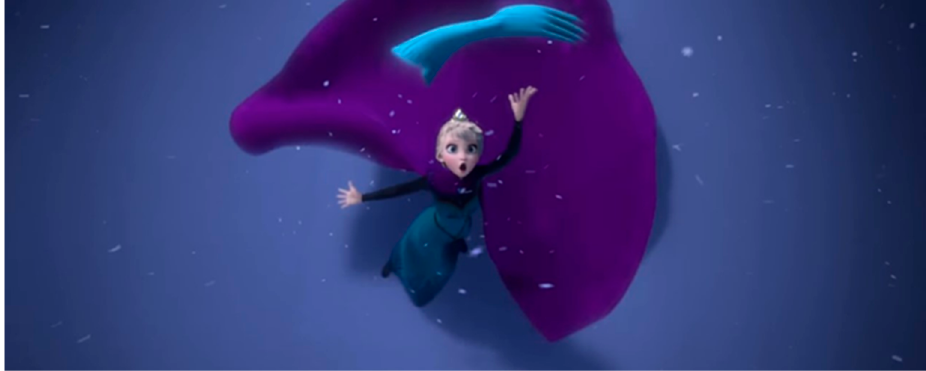
Figure 6. Elsa letting go her glove (Walt Disney Animation Studios 2013a).